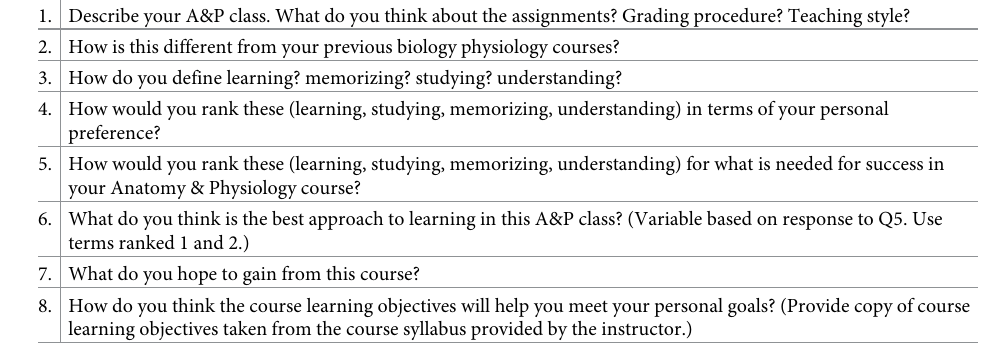
Table 1. Full semi-structured interview protocol, allowing follow-up questions for clarification of responses to each